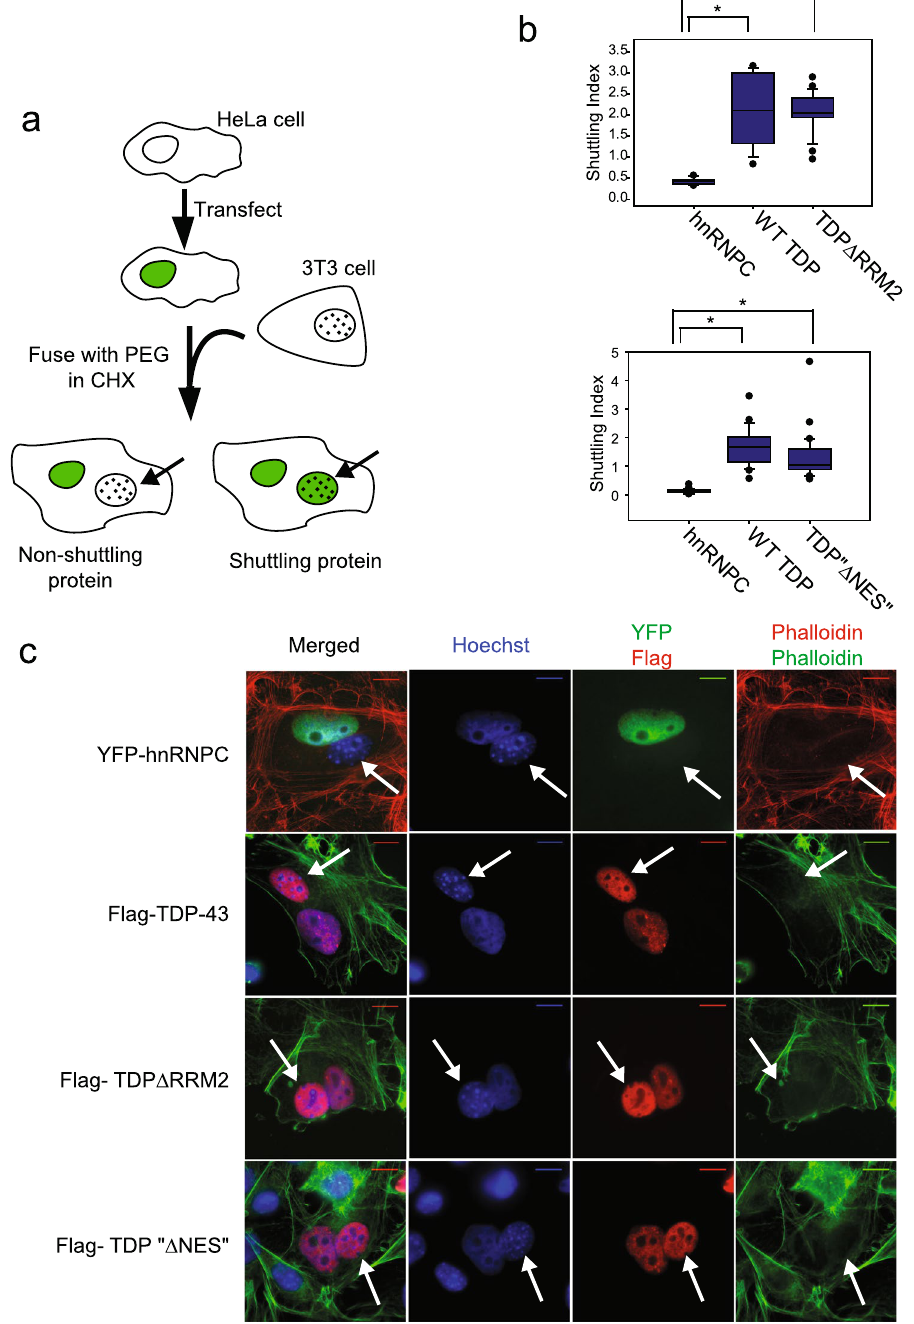
Figure 3. RRM2 is not required for nuclear export, and “ ∆ NES” mutations do not abolish export. ( a ) Schematic of heterokaryon shuttling assay. ( b ) Quantification of shuttling assay. For each heterokaryon counted, the ratio of fluorescence in recipient nucleus/donor nucleus was plotted (normalized to background). Results are shown in box and whiskers plot. Top: 3 independent experiments. hnRNPC- 6 heterokaryons counted; WT TDP-43 − 9 heterokaryons counted; TDP-43 ∆ RRM2–19 heterokaryons counted. * indicates significant difference between groups, p < 0.002 using Mann-Whitney Rank Sum Test. No significant difference between WT and ∆ RRM2. Quantification of shuttling assay from three independent experiments as above. hnRNPC- 22 heterokaryons counted; WT TDP-43–24 heterokaryons counted; TDP-43 “ ∆ NES” – 26 heterokaryons counted. * indicates significant difference between groups, p < 0.001 using Mann-Whitney Rank Sum Test. No significant difference between WT and “ ∆ NES”. ( c ) Images of sample heterokaryons shown. Nuclei are stained with Hoechst. YFP- hnRNPC is detected by direct fluorescence. Flag WT TDP-43, Flag TDP-43 ∆ RRM2, and Flag TDP-43 “ ∆ NES” are detected by immunofluorescence with Flag antibody. Actin cytoskeleton visualized with phalloidin stain. Recipient nucleus (3T3) indicated by arrow. Scale bars- 10